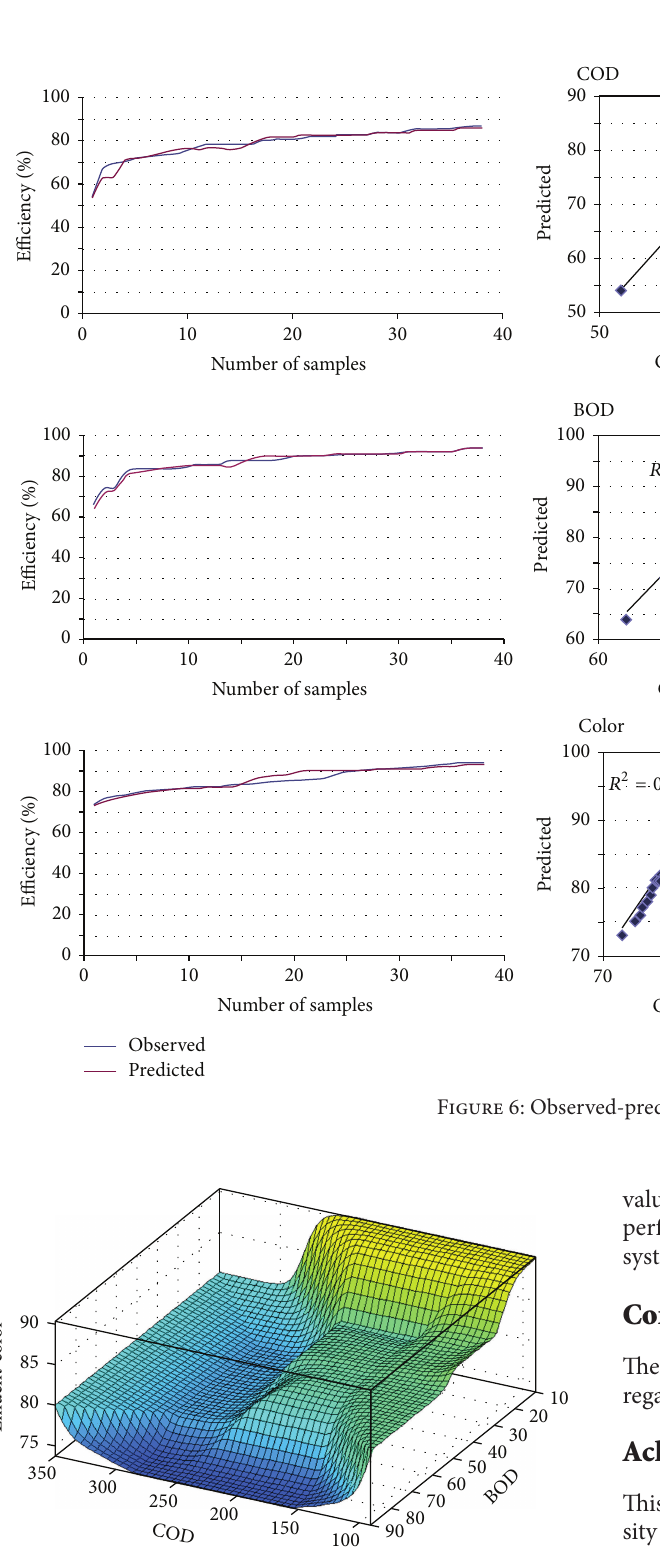
Figure 7: Surface map of color removal according to influent values.